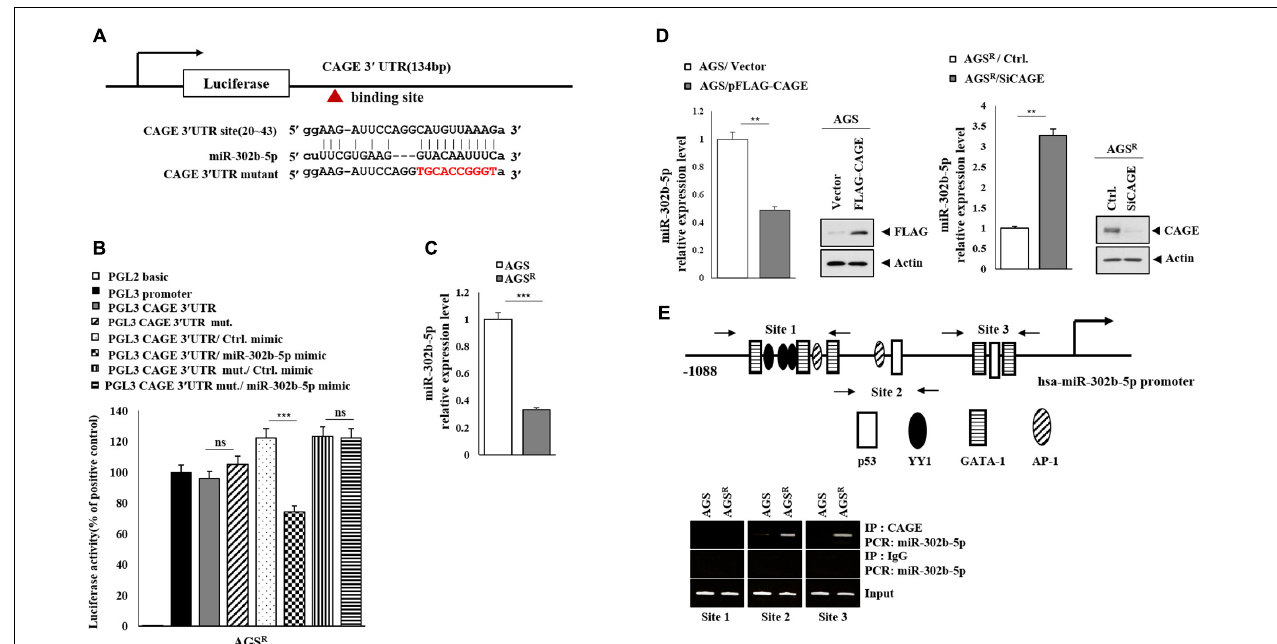
FIGURE 4 | CAGE and miR-302b-5p form a negative feedback loop. (A) Shows the binding site for miR-302b-5p in the 3 (cid:48) UTR of CAGE. (B) After 48 h of transfection, luciferase activity assays were performed as described. ***, p < 0.001. Average values of three independent experiments are shown. Ns denotes not significant. (C) qRT-PCR analysis was performed. ***, p < 0.001. Average values of three independent experiments are shown. (D) After 48 h of transfection, qRT-PCR and immunoblot were performed. **, p < 0.01. Average values of three independent experiments are shown. (E) ChIP assays were performed as